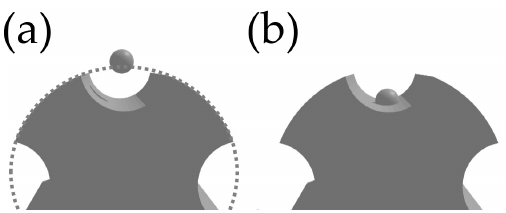
Figure 12. Different collision shapes in Blender. ( a ) Convex hull method and ( b ) Mesh method.